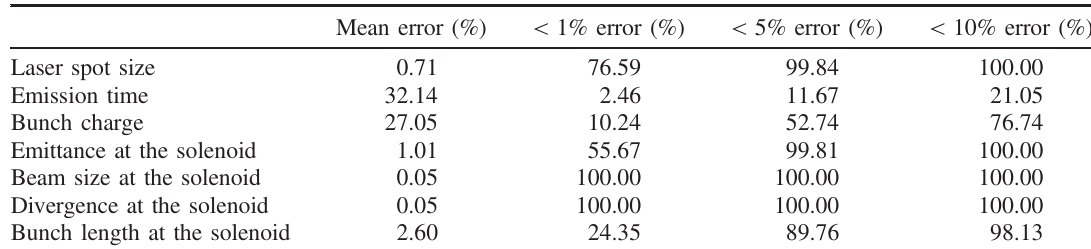
TABLE II. Summary of the prediction performance for the different training label components. The mean error refers to the absolute prediction error and is calculated for the whole verification dataset. The three remaining columns refer to the fraction of the verification dataset within a certain prediction accuracy